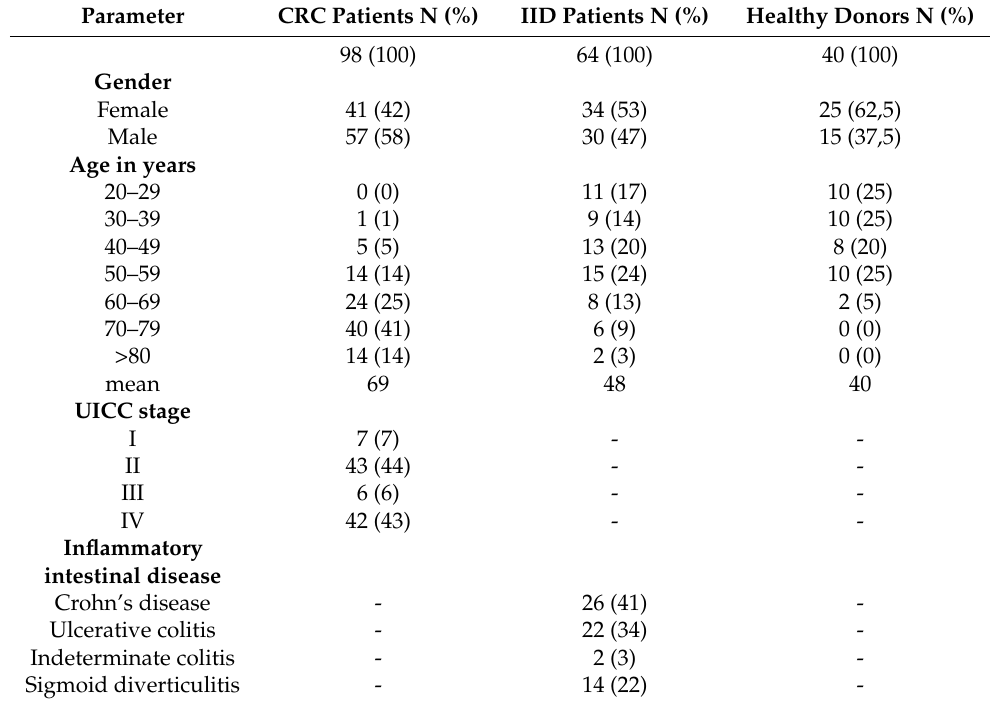
Table 1. Demographics of CRC and IID patients as well as healthy donors along with clinical characteristics of the entire study population.